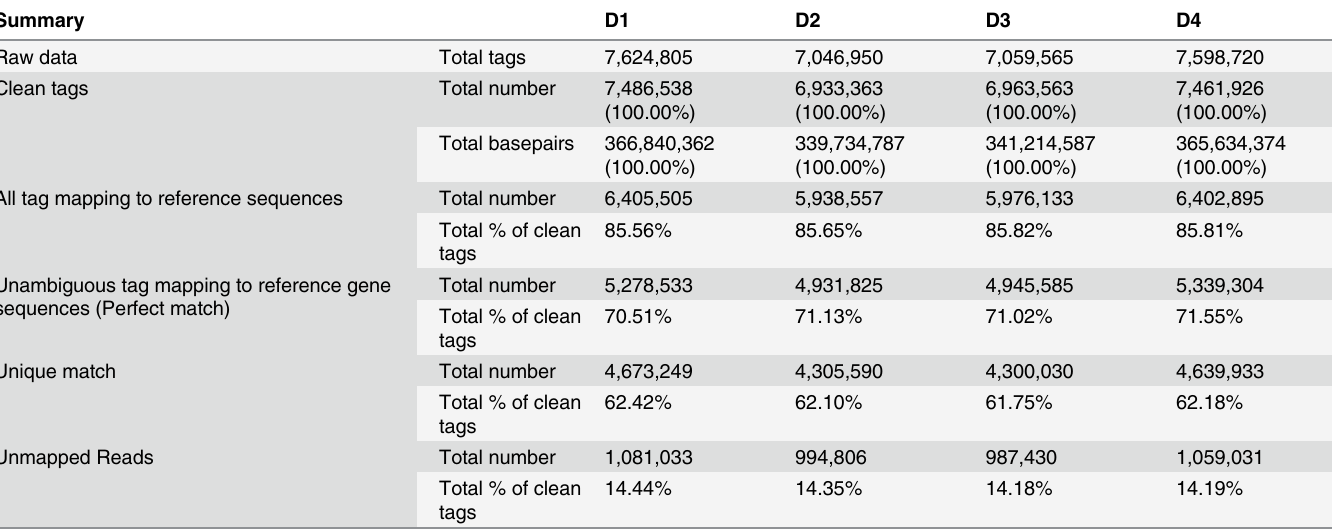
Table 3. Statistics of DGE sequencing.